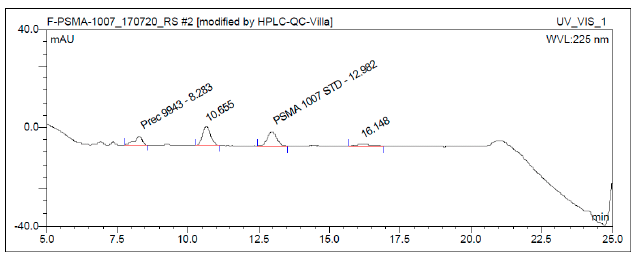
Figure 2. Typical chromatographic radio- and ultraviolet (UV)-traces of [ 18 F]PSMA-1007 injection solution (ABX advanced chemical compounds) using the one-step method (Prec. = Precursor).